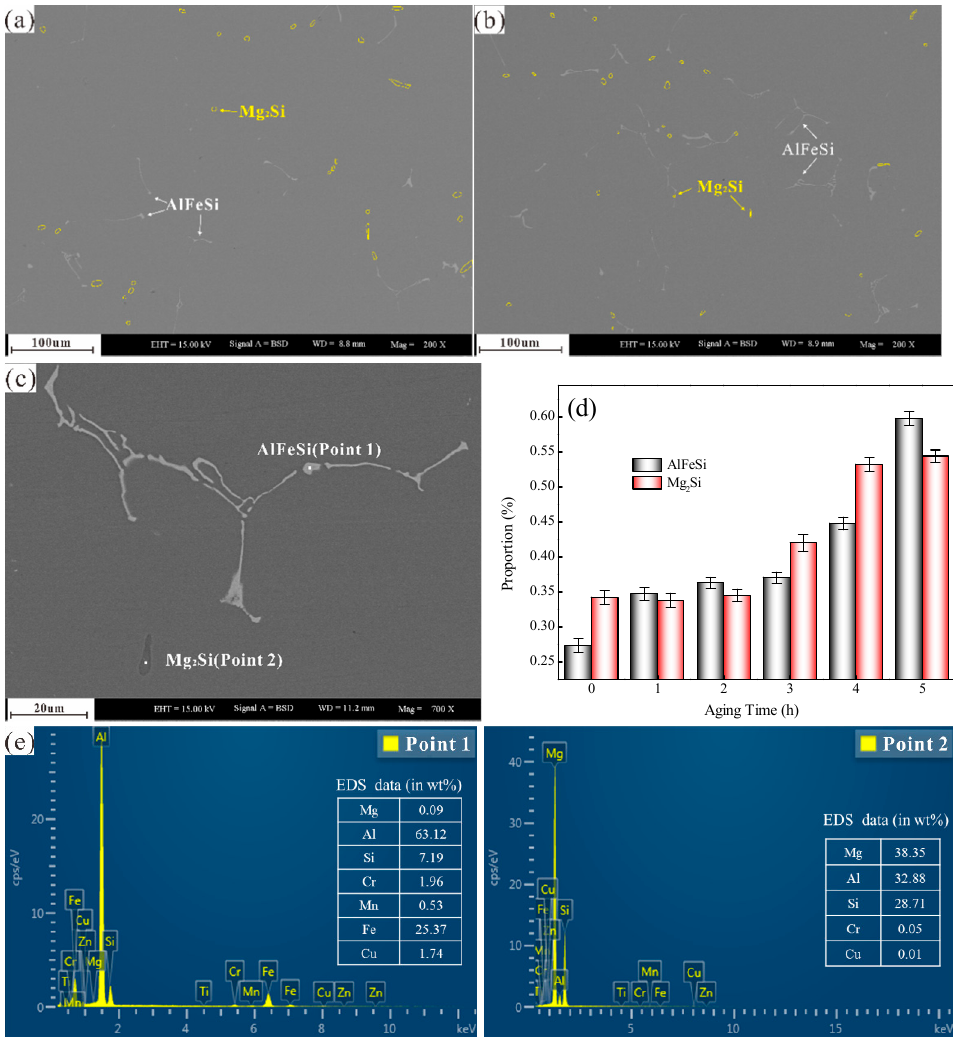
Figure 5. Scanning electron microscopy (SEM) analyses of second phases in different artificial ageing times at 180 °C: ( a )1 h, ( b ) 5 h, ( c ) local enlarged view of second phases aged at 180 °C for 5 h, ( d ) volume fraction of the AlFeSi phase and Mg 2 Si phase under different ageing time (0 h, 1 h, 2 h, 3 h, 4 h and 5 h), and ( e ) energy-dispersive X-ray spectroscopy (EDS) analyses of ( c ).